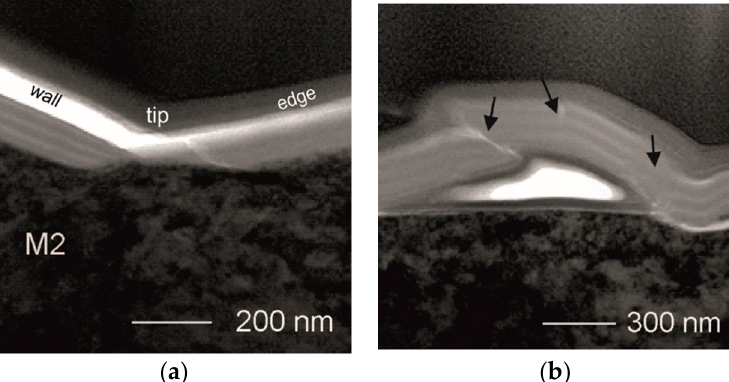
Figure 5. TEM BF images of the microstructure of annealed sample, after indentation (single indentation mode, max. load 150 mN): ( a ) material intermixing in the coating area observed along the edge of indentation and under the tip, ( b ) local delamination of the coating from the substrate and disturbances in the arrangement of layers, observed on the top of the coated sample, near the indentation area.